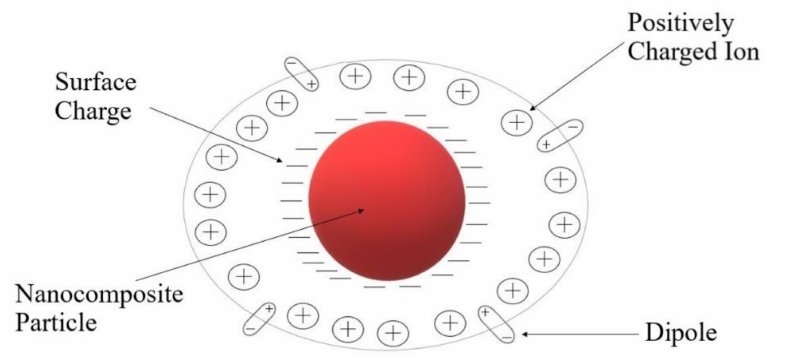
Figure 2. Schematic representation of the space charge and local electric field formation around a nanocomposite